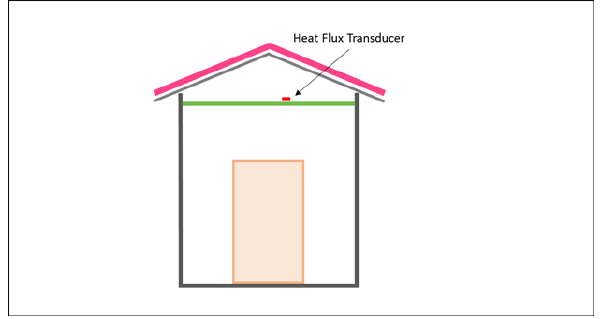
Figure 9: Heat flux transducer on ceiling